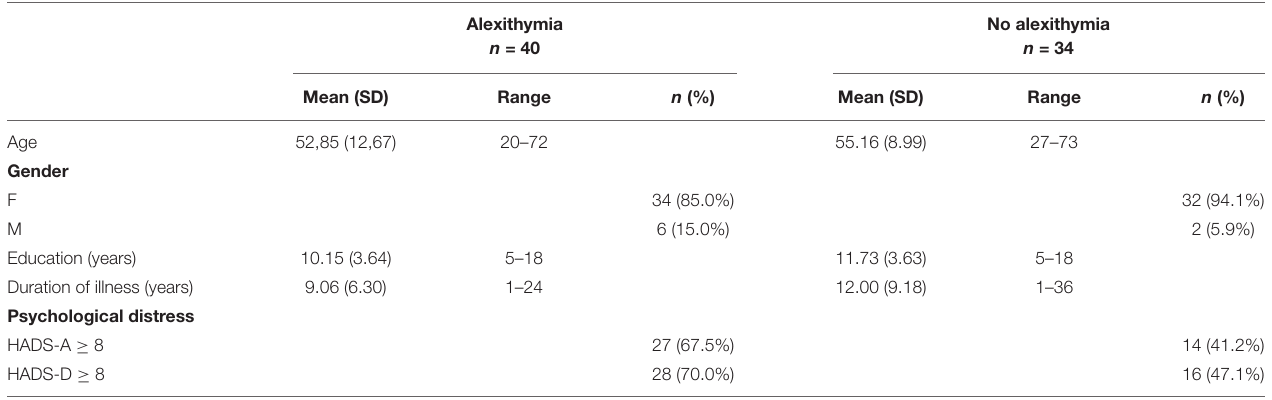
TABLE 4 | Demographic characteristics and prevalence in alexithymia vs. no alexithymia groups.